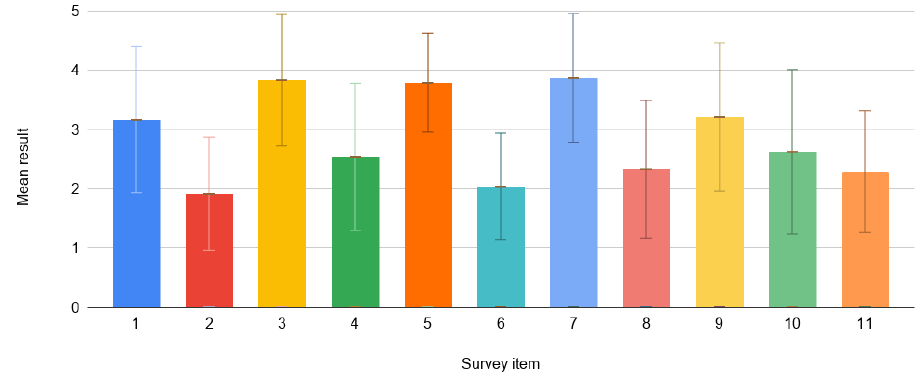
Figure 6. Survey results, each item